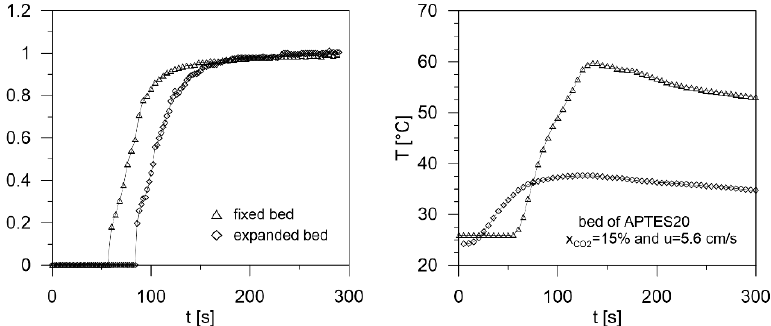
Figure 14. Effect of gas velocity on the breakthrough curves for APTES20 in confined expanded bed with 15% CO 2 .